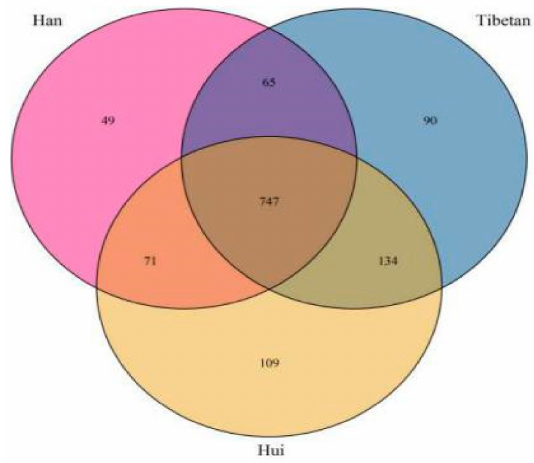
Figure 5. VENN analyses among the three ethnic